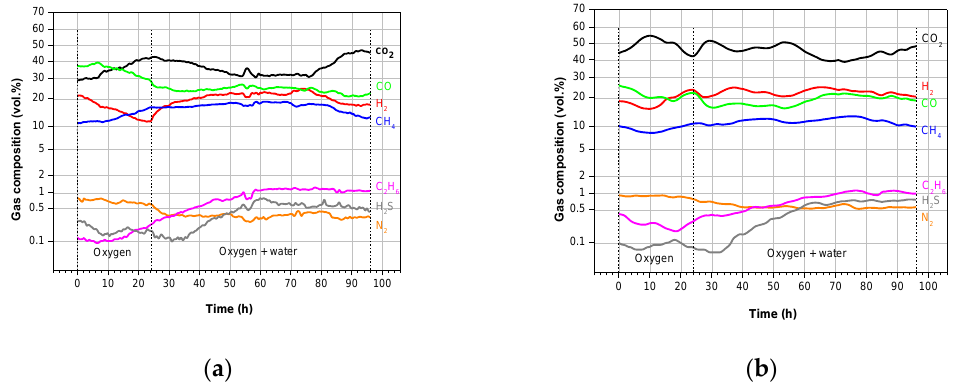
Figure 6. Changes in gas composition over the course of gasification experiments at 20 bar: ( a ) “Six Feet” semi-anthracite, ( b ) “Wesoła” hard coal.